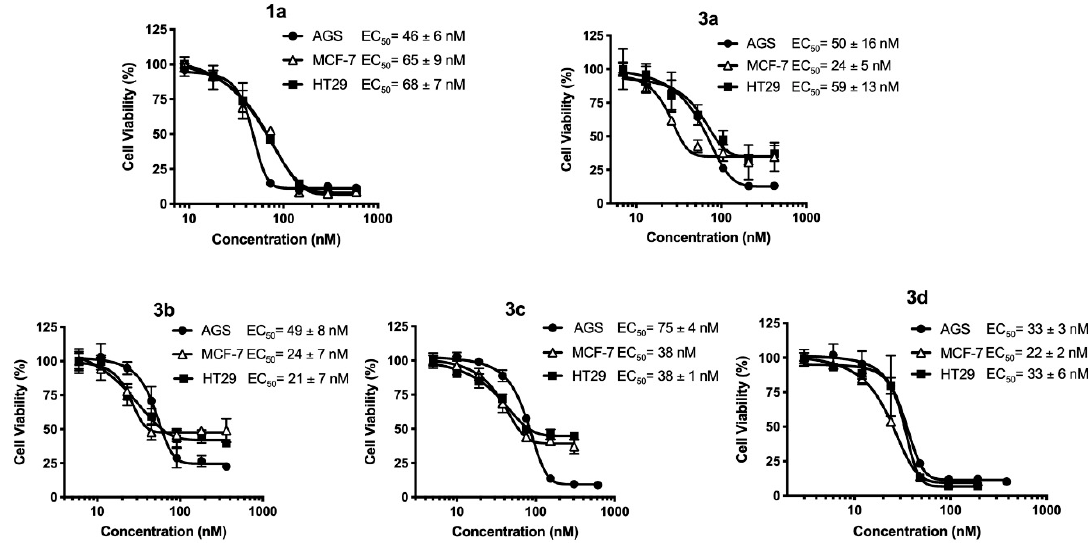
Figure 3. EC 50 determination of Myrtenyl derivates. Dose-response curves and corresponding EC 50 values of Myrtenyl derivates were determined after 24 h of drug treatment in AGS, MCF-7, and HT-29 cells lines by Sulforhodamine B assay. Viability is expressed as % compared to control, and data represent mean ± standard deviation of triplicated determinations in three independent experiments.